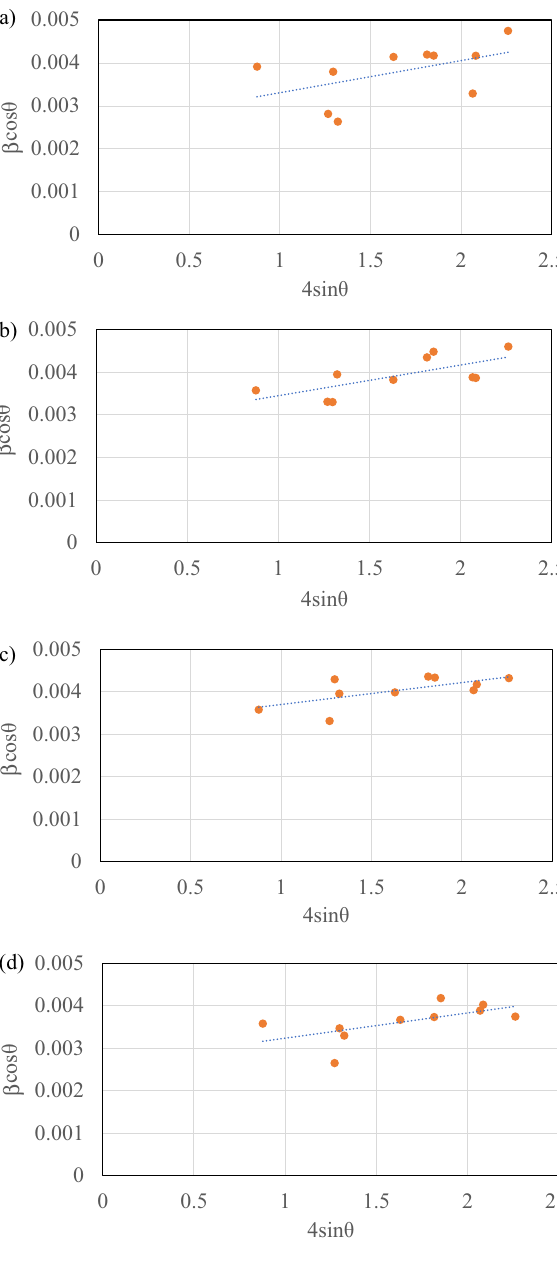
in the synthesized AuNP/TiO 2